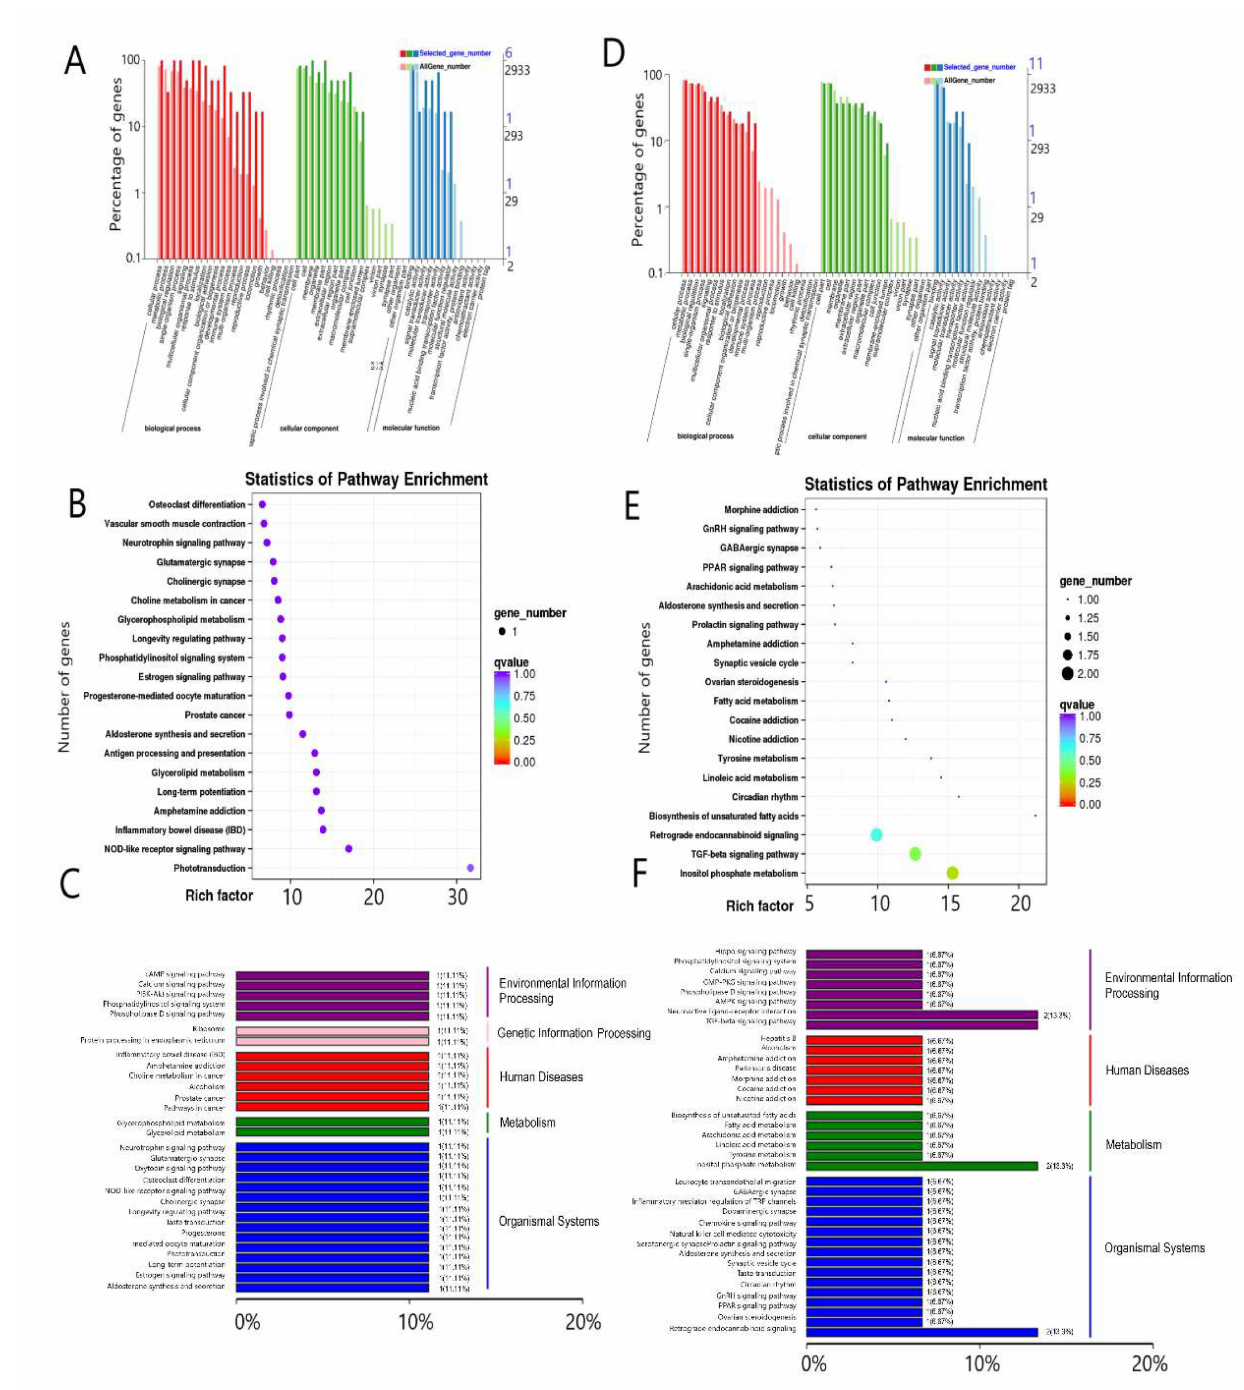
Figure 3. DEG annotation and enrichment in the pituitary and hypothalamus. DEG GO annotation classification chart of the pituitary gland ( A ) and hypothalamus ( D ). DEG scatter plot of KEGG path- way enrichment of the pituitary gland ( B ) and hypothalamus ( E ). DEG KEGG pathway classification of the pituitary gland ( C ) and hypothalamus ( F